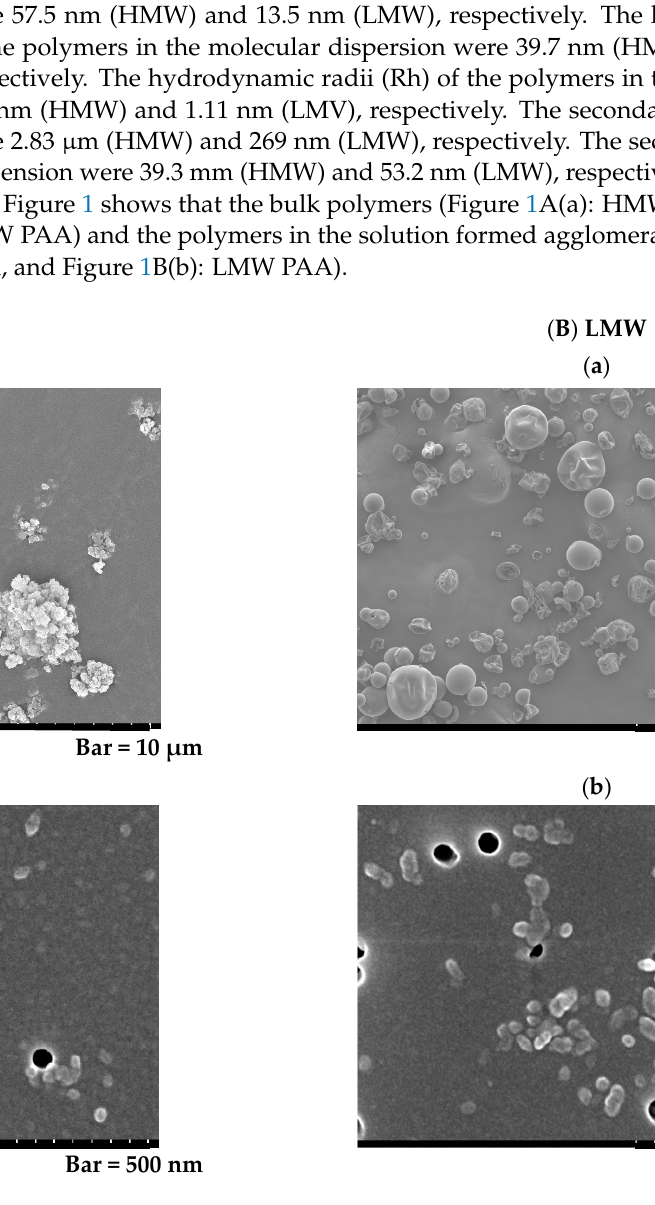
Figure 1. Scanning electron microscopy (SEM) images of the polymers used in the present study. The bulk HMW and LMW PAA powders and the suspended HMW and LMW PAA in distilled water are shown in ( A ( a )) and ( B ( a )), and ( A ( b )) and ( B ( b )), respectively. They all formed agglomerates. (Internal scale bar = 10 µ m for ( A ( a )), 500 nm for ( A ( b )), 500 µ m for ( B ( a )) and 500 nm for ( B ( b ))). No endotoxin was detected in any of the polymer